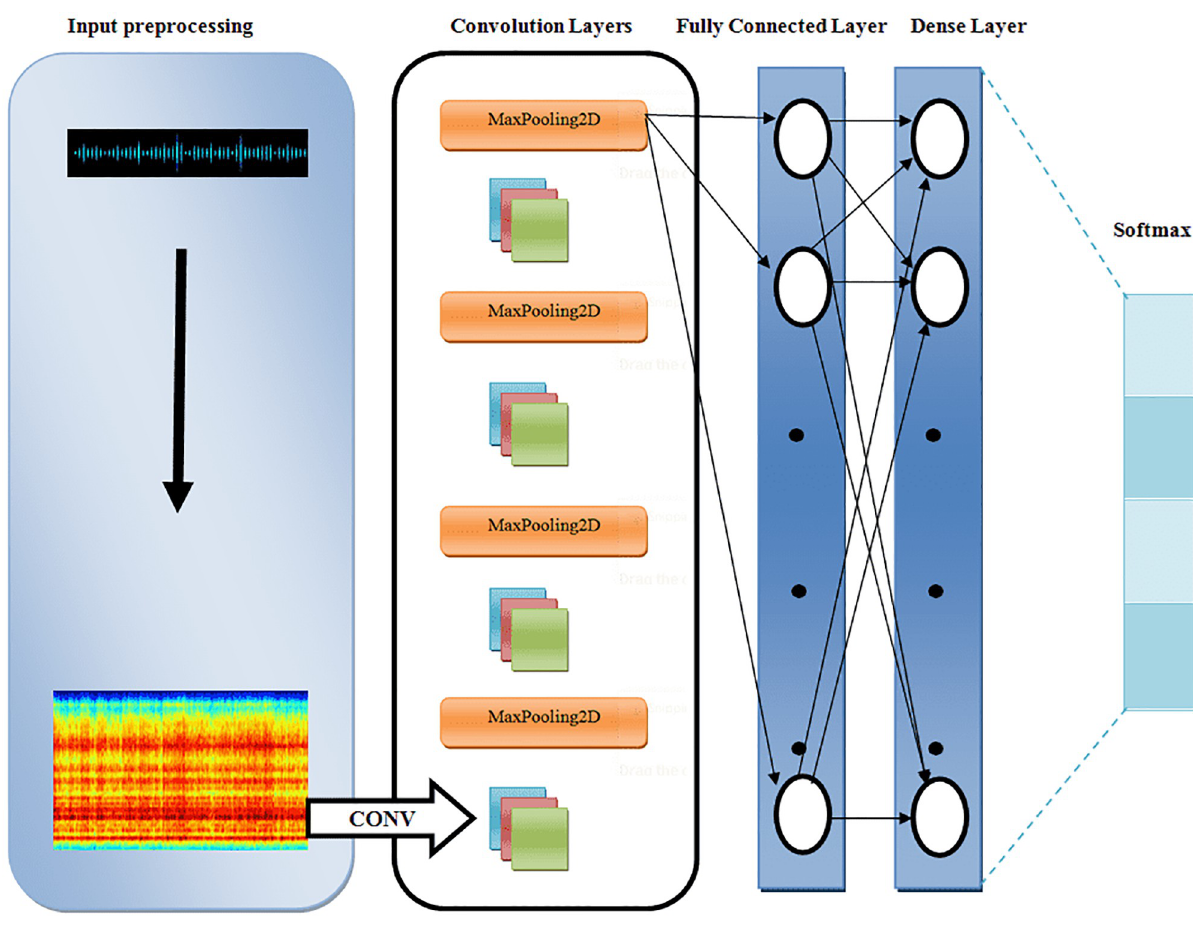
Fig 1. EKM architecture used in